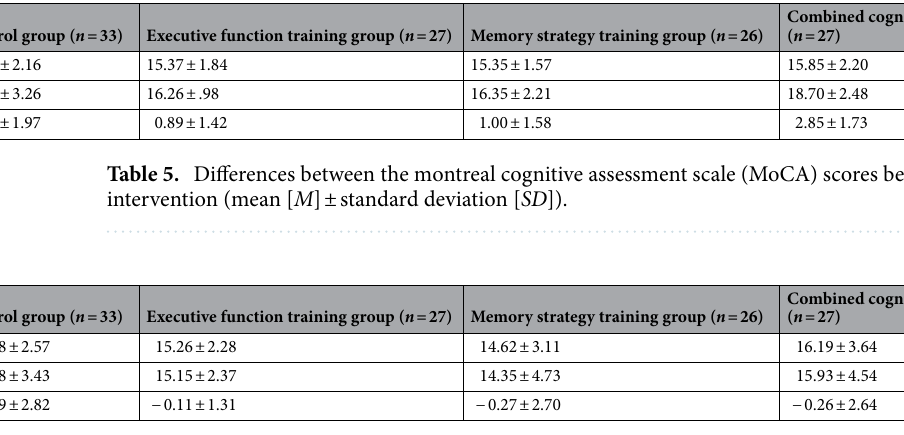
Table 6. Differences between the instrumental activities of daily living scale (IADL) scores before and after intervention (mean [ M ] ± standard deviation [ SD